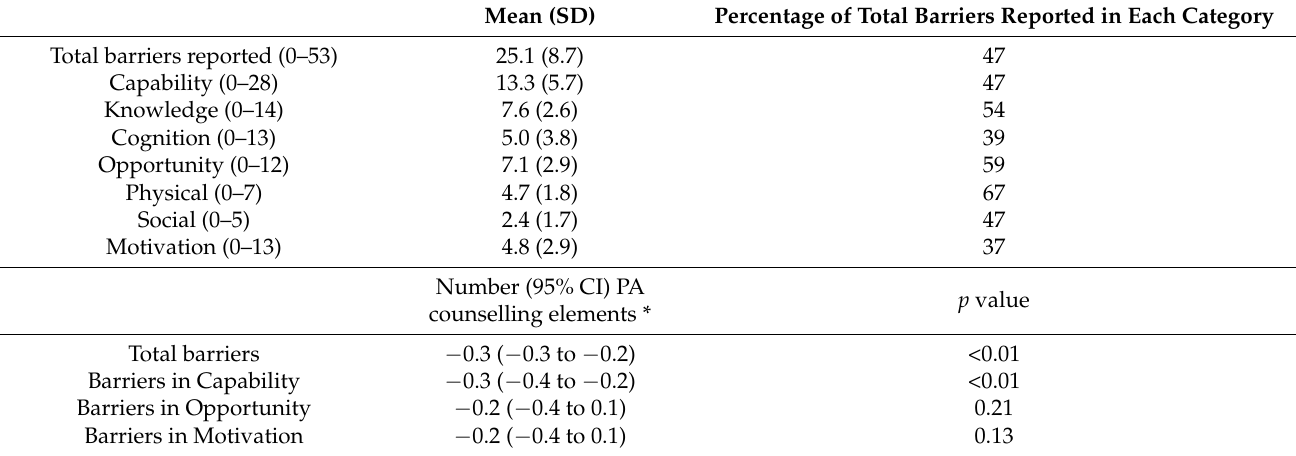
Table 4. Number of barriers to physical activity counselling reported by physiotherapist by aspects of the COM-B framework and their relationship with the total number of elements of PA counselling used ( n = 84). Mean (SD) Percentage of Total Barriers Reported in Each Category Total barriers reported